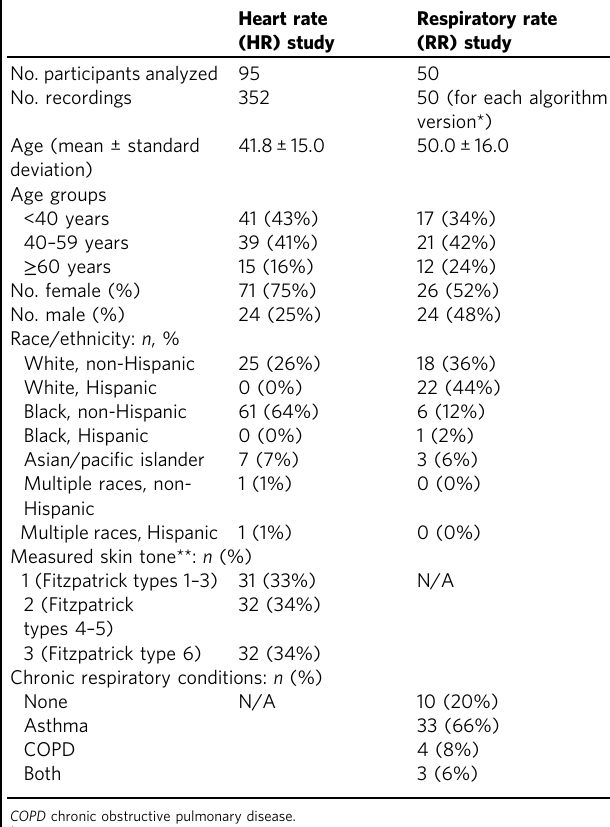
Table 1 Baseline characteristics of the study